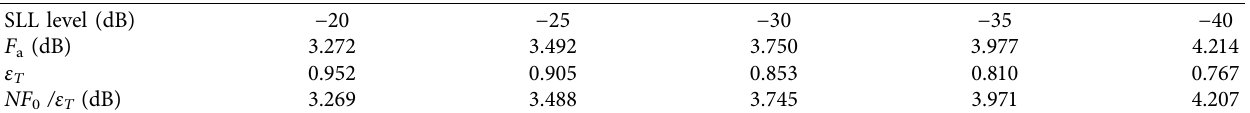
Figure 9: (a) Noise fgure of each branch versus T/R attenuation. (b) T/R module weighting coefcient in the elevation direction. Table 2: Antenna noise fgure results for Taylor